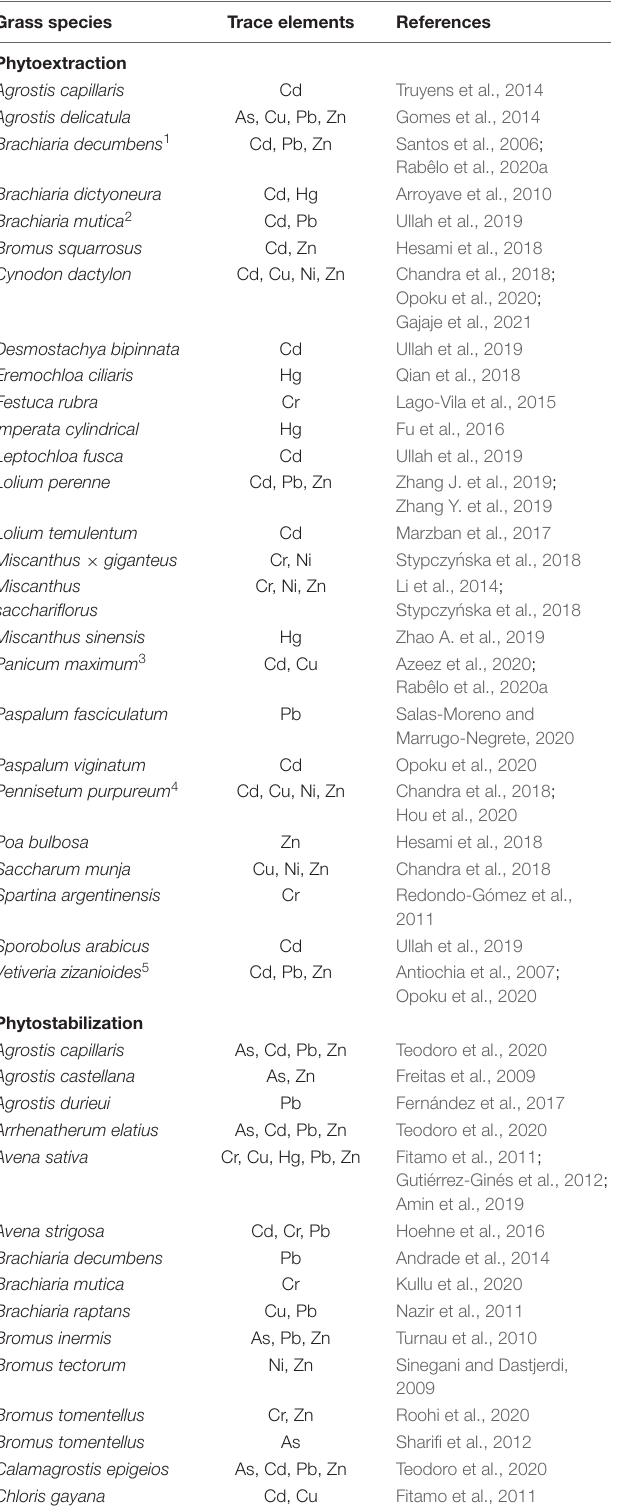
TABLE 2 | Examples of suitable grass species for each strategy of phytoremediation in sites contaminated with potentially toxic trace